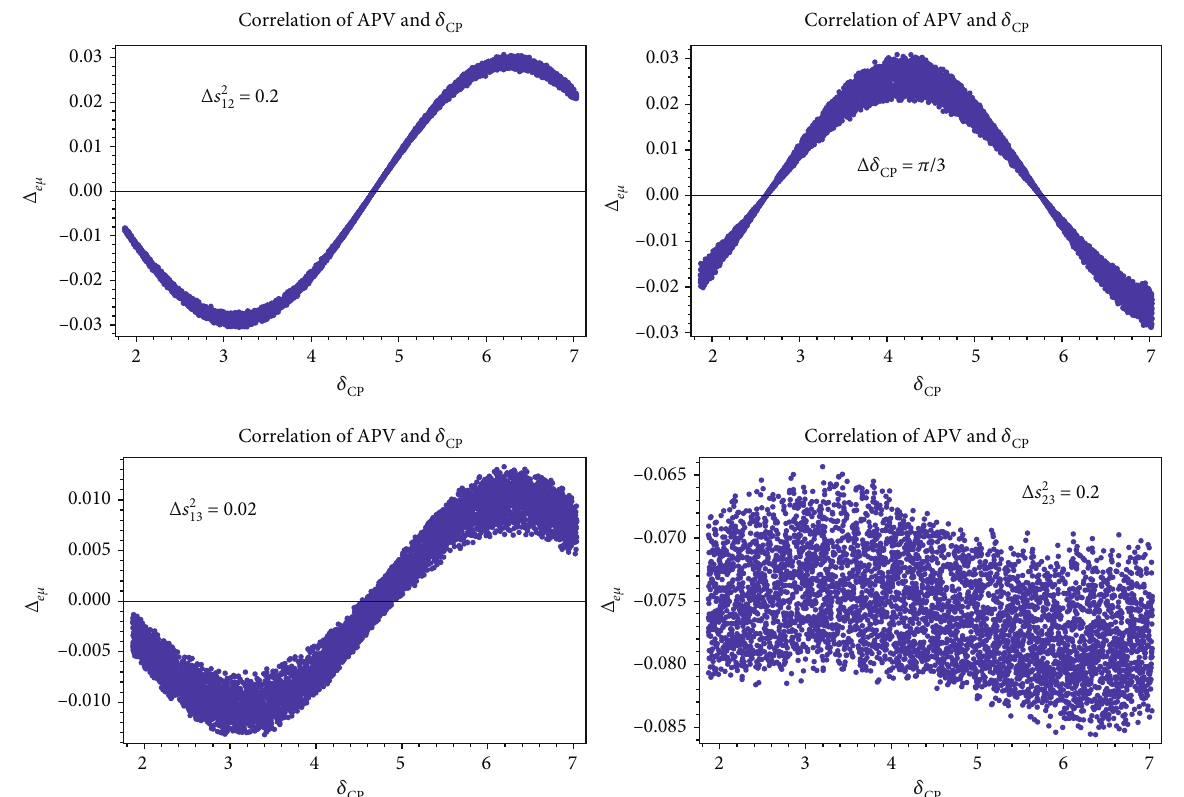
Figure 6: The correlation between the apparent P violation (APV) and the CP phase. The mixing parameters in U are in the 3 σ ranges of the global fi t data of the normal mass ordering [4]. The modi fi ed parameter in U s is fi xed in every plot. The other parameters in U s are the same as those in U